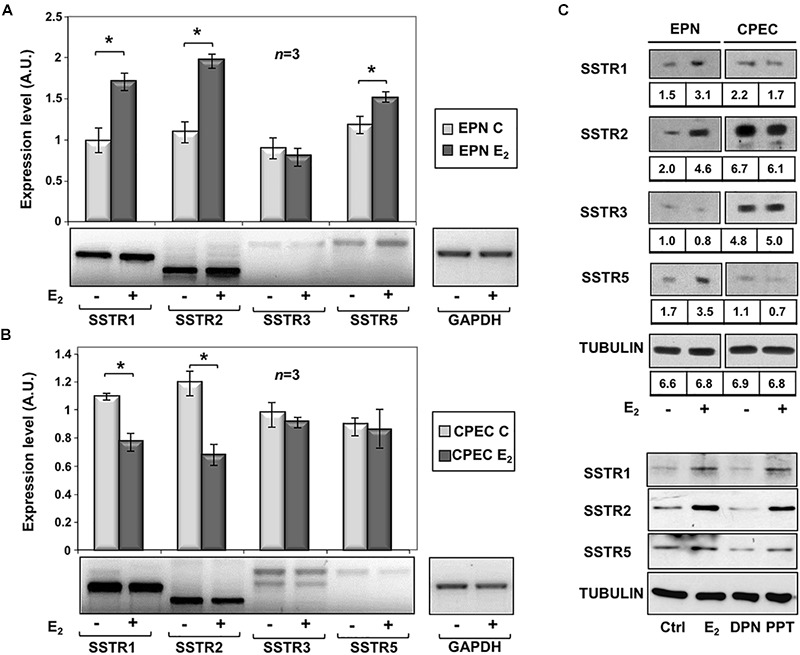
Effect of estradiol on SSTRs mRNA and protein expression levels. RT-PCR analysis of SSTR1, 2, 3 and 5 mRNA levels in EPN (A) or CPEC (B) cells untreated or treated for 24h with 20 nM estradiol (E2) was done. In panel (A,B), densitometry analysis of agarose gel electrophoresis is shown. The expression level is indicated as fold changes over the basal conditions (A.U.). Histograms represent the averages (+/– standard error) from 3 independent experiments, normalized for the expression of the control housekeeping gene GAPDH (∗indicates p < 0.05 for each gene versus its untreated control). Means and SEMs are shown. n represents the number of experiments. ∗p < 0,05. Insets are representative from one experiment in A or B. In panel (C, upper section), the Western blot analysis of lysate proteins from EPN and CPEC cell lines untreated or treated with estradiol (20 nM; E2) for 48 h was done. Lysate proteins (1 mg/ml) were resolved by SDS–PAGE, transferred to PVDF membrane and probed with anti-SSTRs or anti-tubulin antibodies. Inset in panel (C), densitometry analysis of SSTRs was done in two different experiments using the NIH/Image J software. Results were expressed as relative change over the basal level of each SSTR isoform. In panel (C, lower section), the Western blot analysis of lysate proteins from EPN cells untreated or treated with estradiol (20 nM; E2) or PPT (3 nM) or DPN (3 nM) for 48 h was done. Lysate proteins (2 mg/ml) were resolved by SDS–PAGE, transferred to nitrocellulose membrane and probed with the antibodies against the indicated proteins. In panel (C, upper and lower sections), the Western blot analysis of tubulin is shown, as loading control.